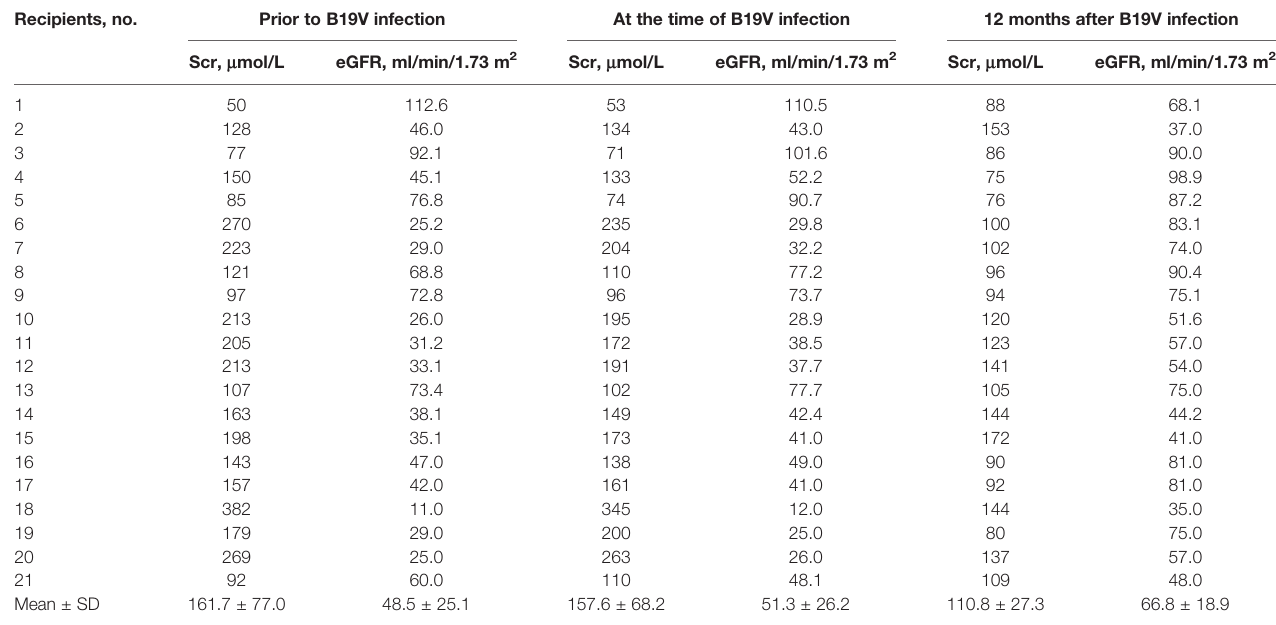
TABLE 4 | The impact of B19V on allograft function in donor-derived infection after kidney transplantation. Recipients,